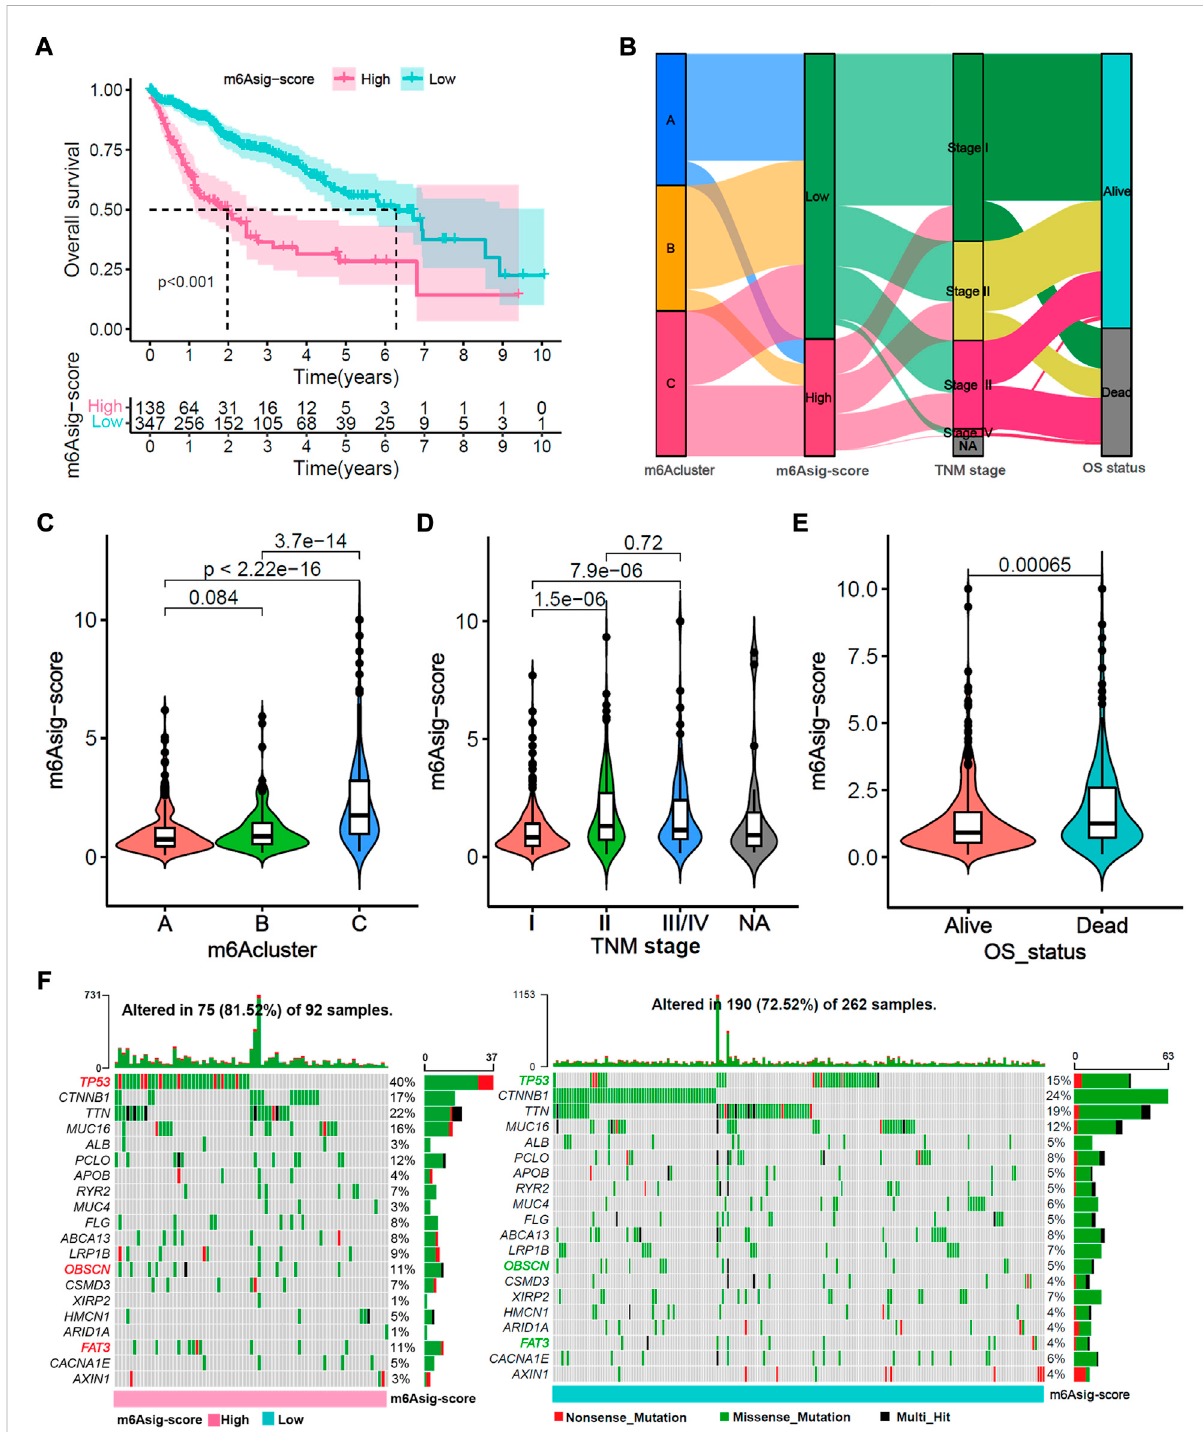
FIGURE 6 Relevance exploration of m6Asig-Score with clinical features and tumor somatic mutation. (A) Overall survival Kaplan-Meier analysis for high and low m6Asig-Score groups in merged HCC cohort ( p < 0.001, Log-rank test). (B) The Alluvial diagram explained the analysis work fl ow of m6Acluster, m6Asig-Score, TNM stages and survival status. (C – E) The m6Asig-Score was compared among distinct m6Acluster, TNM stage and OS status. (F) The tumor somatic mutation waterfall between high m6Asig-Score (left) and low m6Asig-Score (right) subgroup in the TCGA-LIHC cohort. The upper number of the bar plot indicated tumor mutation burden (TMB), and the right number showed mutation